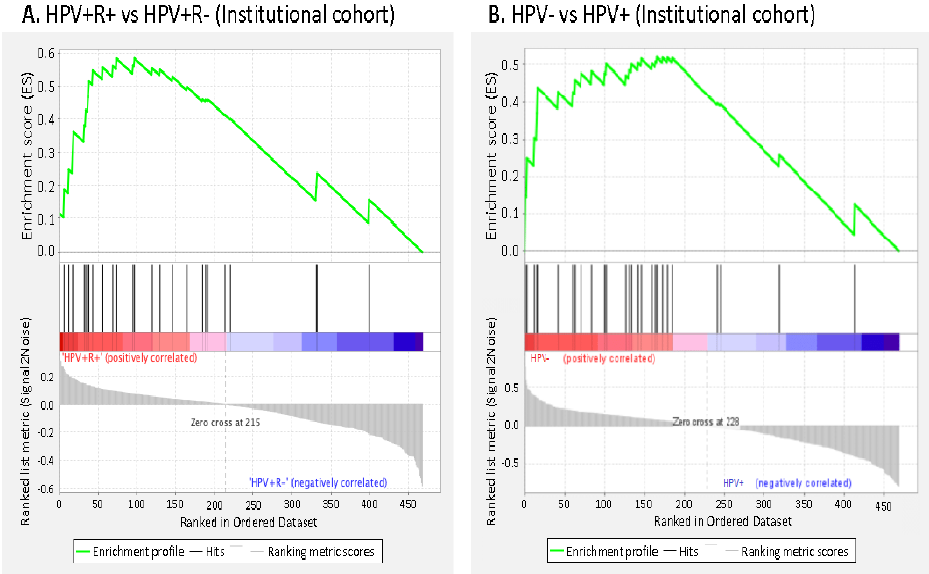
Figure 3. Suppressive Monocytes/macrophages are significantly enriched in HPV- patients and HPV+R+ patients. Using GSEA pathway analysis, in the institutional cohort: ( A ). HPV+R+ patients showed a significant correlation, with an enriched suppressive monocytic pathway when compared to HPV+R- (nominal p -value = 0.004, FWER p -value = 0.039). ( B ). HPV- patients, when compared to HPV+ patients, demonstrated a similar enrichment in suppressive monocyte cell pathways (nominal p value < 0.001, FWER p -value = 0.014).